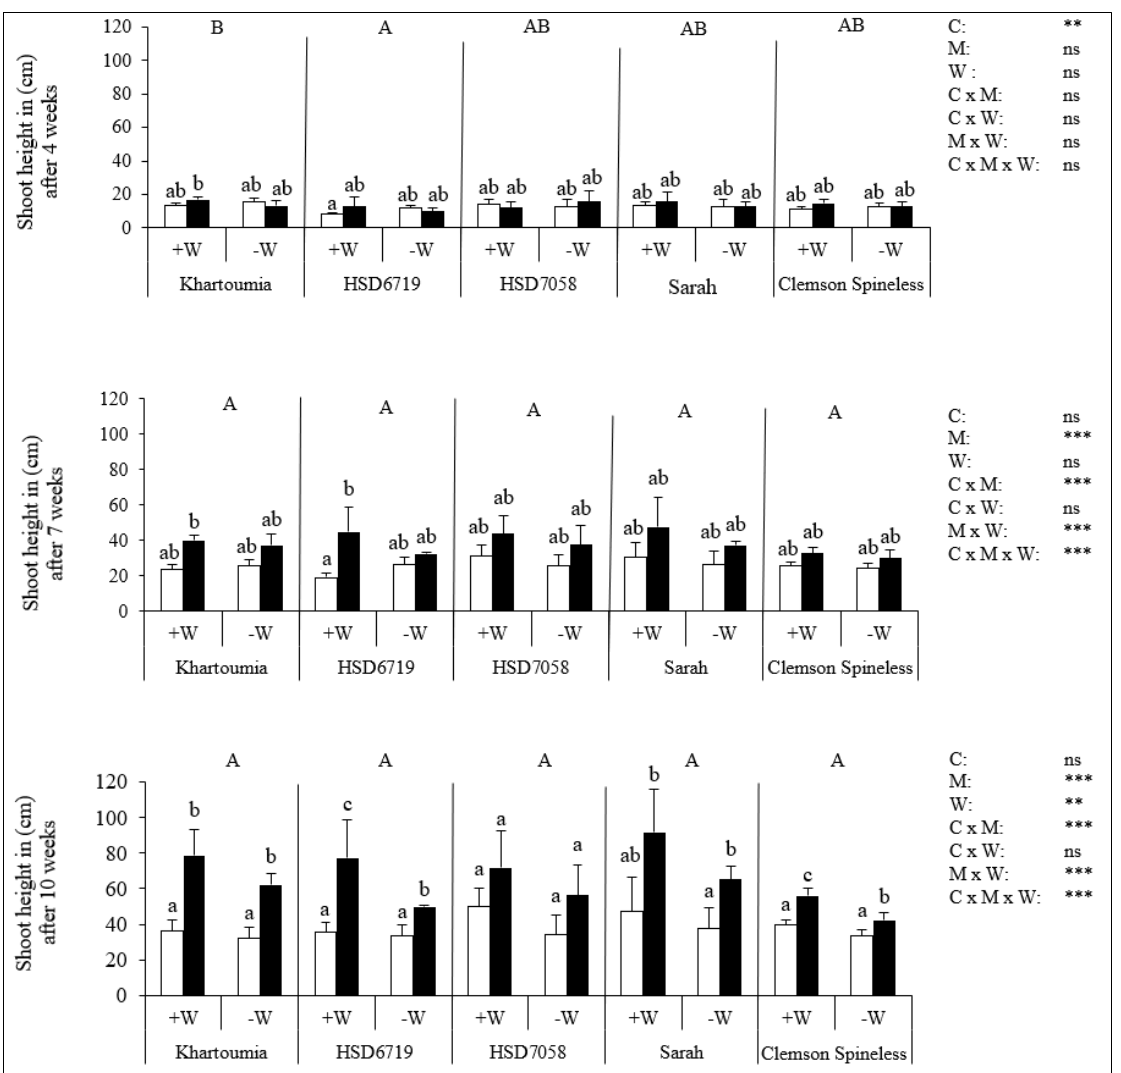
Figure A1. Shoot height (cm) of five okra cultivars measured 4, 7 and 10 weeks after seeding. Plants were non-inoculated (white bars) or inoculated with R. irregulare (black bars). Asterisks indicate significant differences of the factors cultivar (C), AM-inoculation (M) and substrate water content (W) and their interactions (Kruskal-Wallis test, n = 4, p < 0.05 (*), p < 0.01 (**), p < 0.001 (***) and p > 0.05 (ns)). Shown are mean values ± standard deviation. Within each cultivar mean values followed by the same small letter are not significantly different (Tukey test, n = 4, p < 0.05). Cultivars followed by the same capital letter are not significantly different (Tukey test, n = 4, p < 0.05).